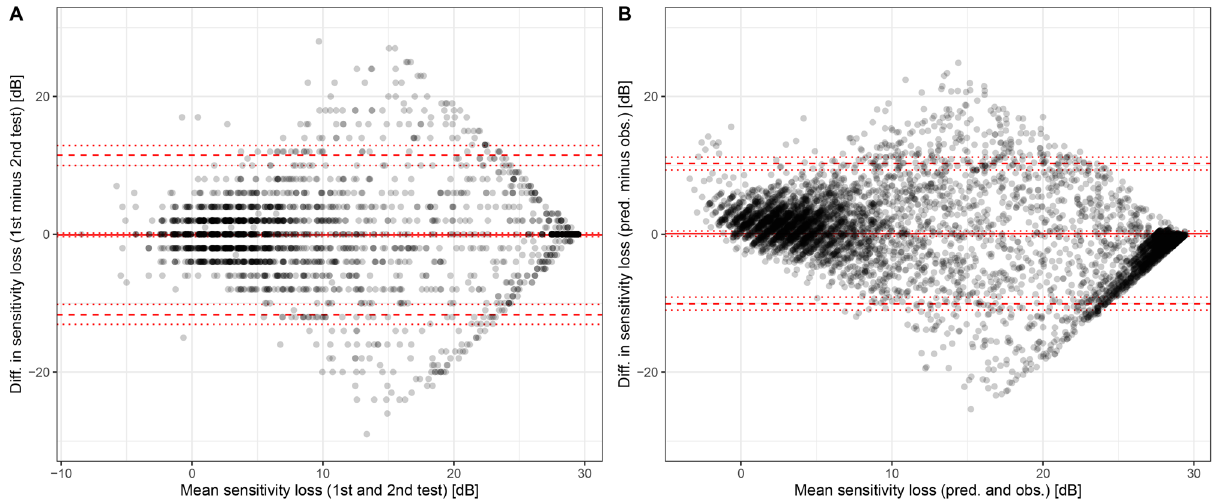
Figure 3. Point-wise retest-variability and prediction accuracy. The differences (diff.) between the first and second microperimetry test were overall slightly larger ( A ) compared to the differences between the cross-validated predictions (pred., feature-set 5) and observations (obs., B ). Severe degrees of sensitivity loss (compared to normative data) appear to be slightly underestimated by the random forest-based predictions. Please note, for the right plot, twice the number of points were available compared to the left plot, since the random forest predictions were compared to the observations from the first and second test separately. The point-wise differences between single test results to the predictions are larger than the point-wise differences between the average of both test runs and the predictions. Thus, the most conservative estimate of the model performance is shown. The estimates for the mean test–retest difference (solid red line) and the 95% limits of agreement (dashed red lines) were computed with consideration of the hierarchical data structure. The dotted lines indicate the 95% confidence intervals for the test–retest difference and limits of agreement. dB